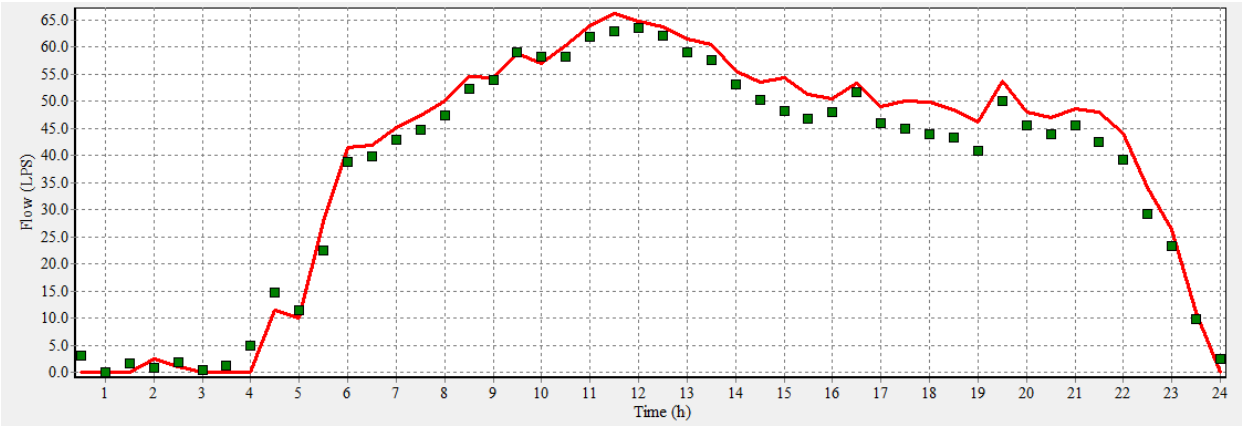
Figure 15. Flow rate calibration.